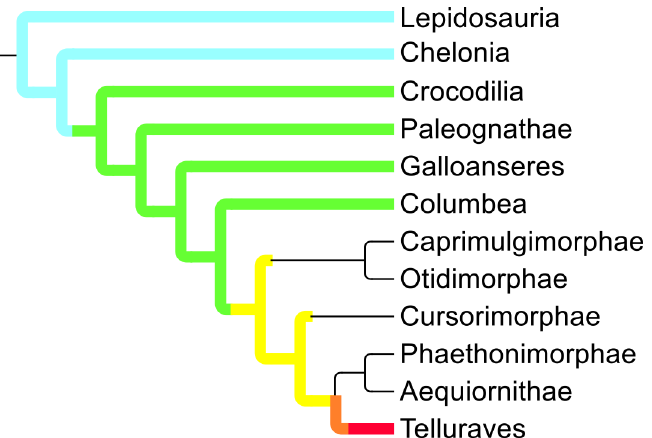
Fig 3. Summary of ancestral hatchling precociality states for extant taxa. Light blue = superprecocial, green = precocial, yellow = semiprecocial, orange = subaltricial, red = altricial, uncoloured = heterogeneous states.